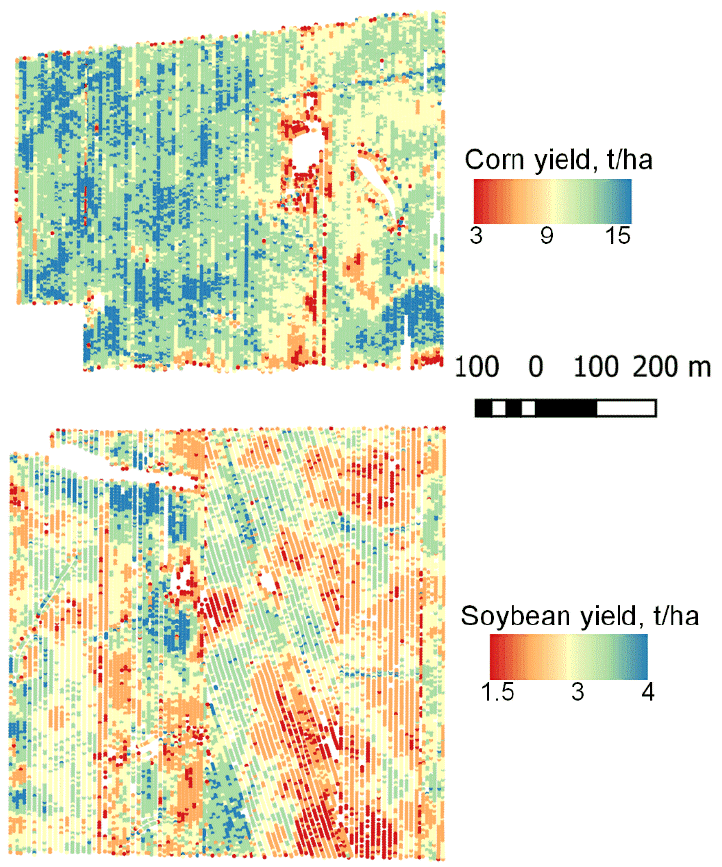
Figure 3. Example of yield distribution over the Coles fields in 2019 as acquired by combine har- vester.